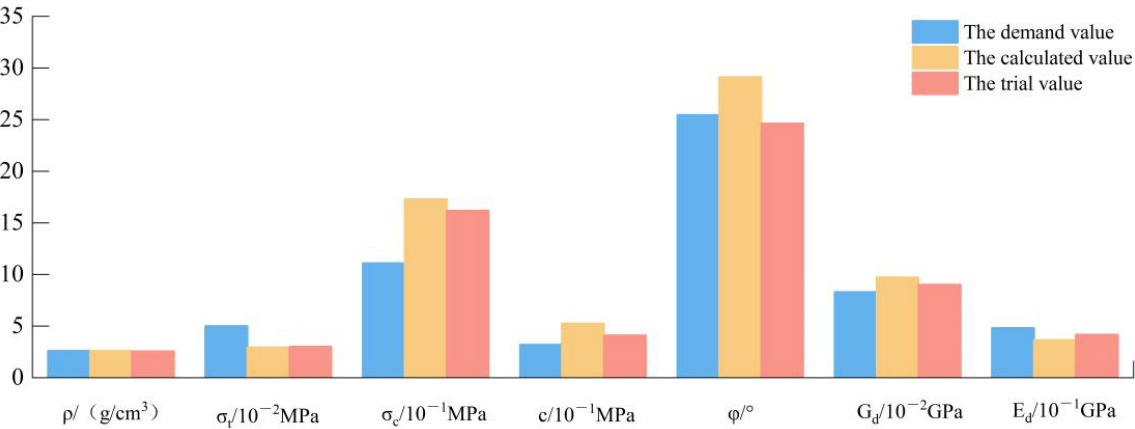
Figure 11. Comparison of physical parameters.